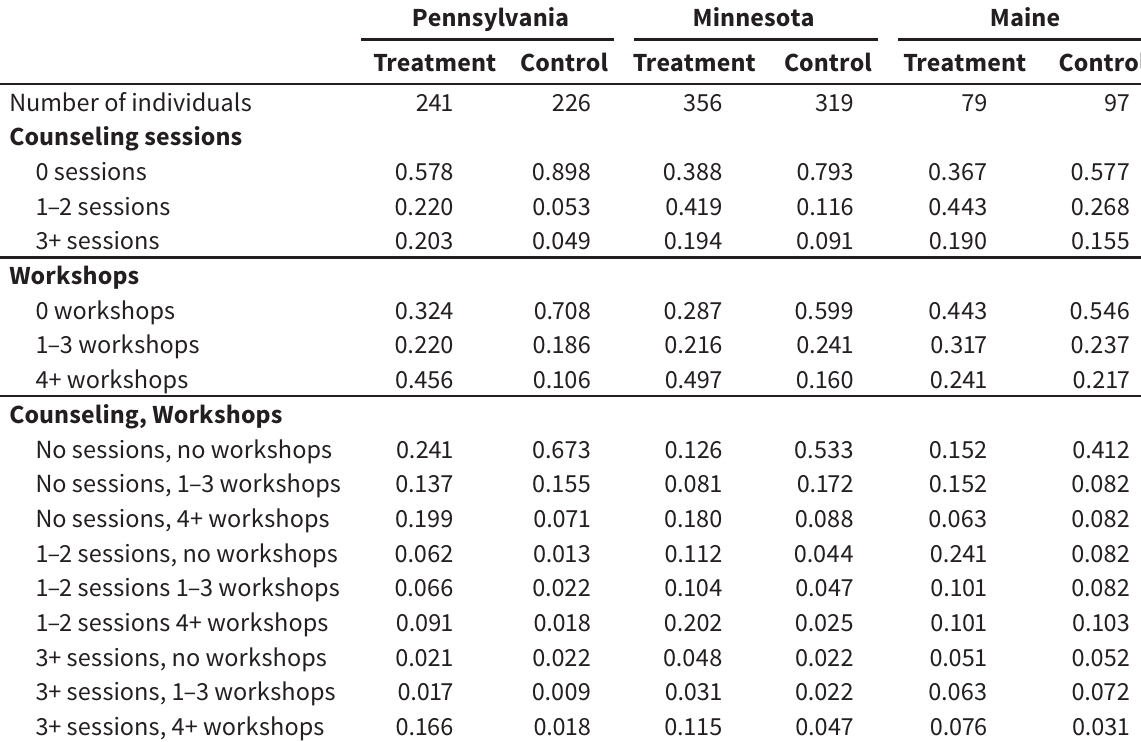
Distribution of counseling sessions and workshops, Project GATE